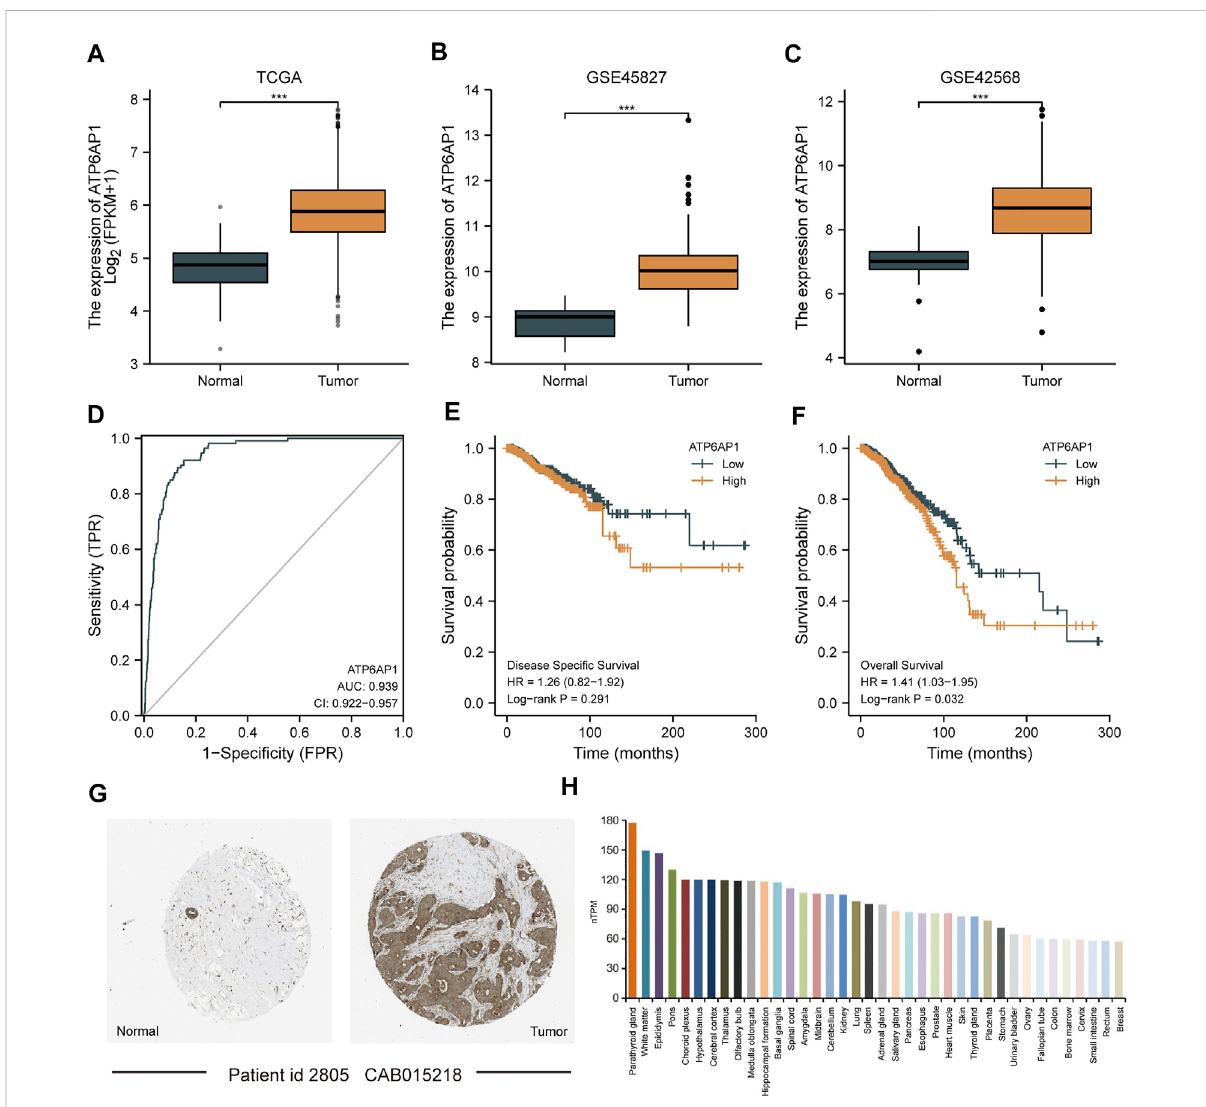
FIGURE 2 ATP6AP1expressioninpatientswithbreastcancer. (A) ExpressionofATP6AP1inunpairedsamplesintheTCGA-BRCAdataset. (B) Expressionof ATP6AP1 in the GSE45827 dataset. (C) Expression of ATP6AP1 in the GSE42568 dataset. (D) Evaluation of ATP6AP1 diagnostic ef fi ciency in breast cancer by drawing ROC curve. (E) Survival analysis of DSS in the ATP6AP1 group with a greater level of expression and a group with a lower level of expression. (F) Survival analysis of OS in ATP6AP1 group with a higher expression level and a group with a lower expression level. (G) Protein expression level of ATP6AP1 in breast cancer tissues and in normal breast tissues. (H) Tissue distribution of top 38 in the expression of ATP6AP1